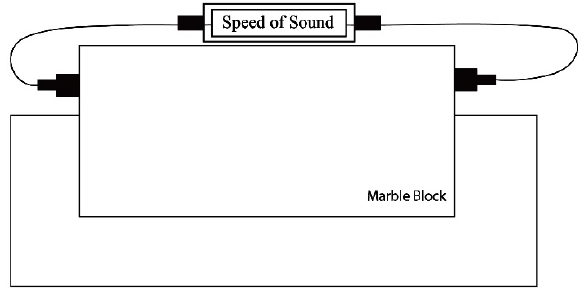
Figure 3. Speed of Sound Measurement.